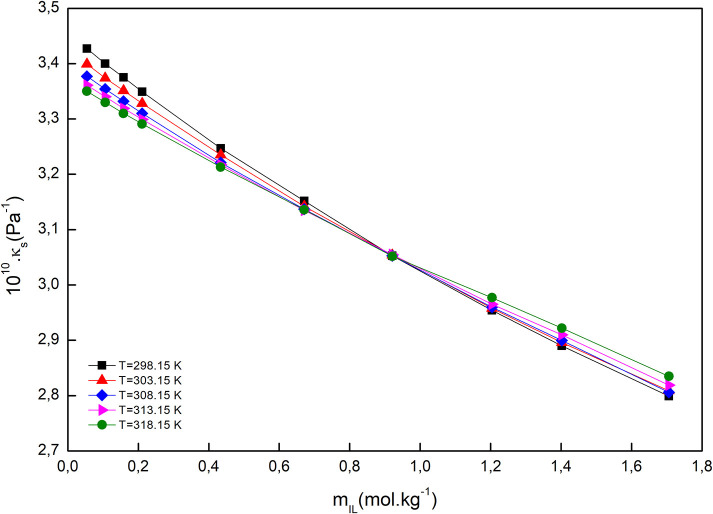
Isentropic compressibility of [C2mim]Cl + H2O + K3PO4 as a function of [C2mim]Cl molality at different temperatures.